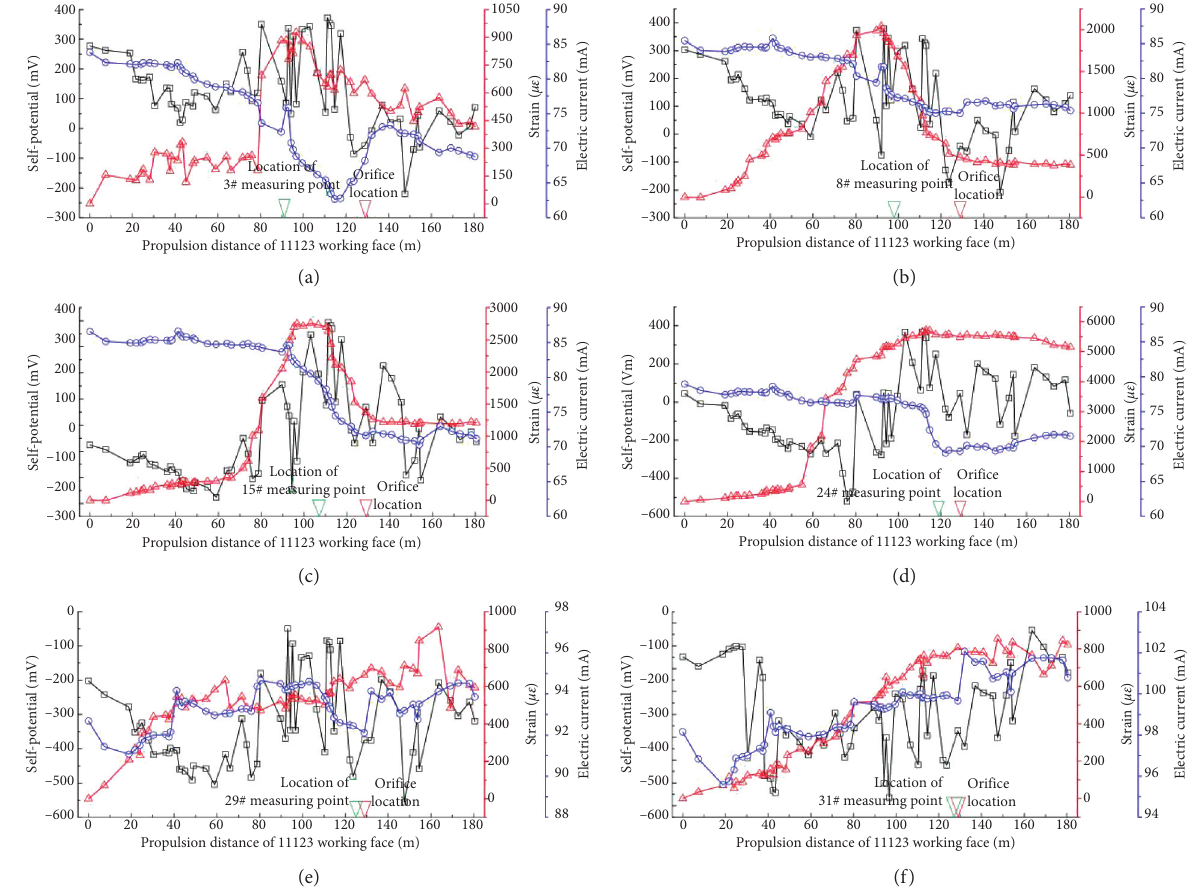
Figure 11: Multiparameter variation in the data obtained at different measuring point depths: (a) 6.13m; (b) 9.18m; (c) 13.45m; (d) 18.94m; (e) 22.6m; (f)